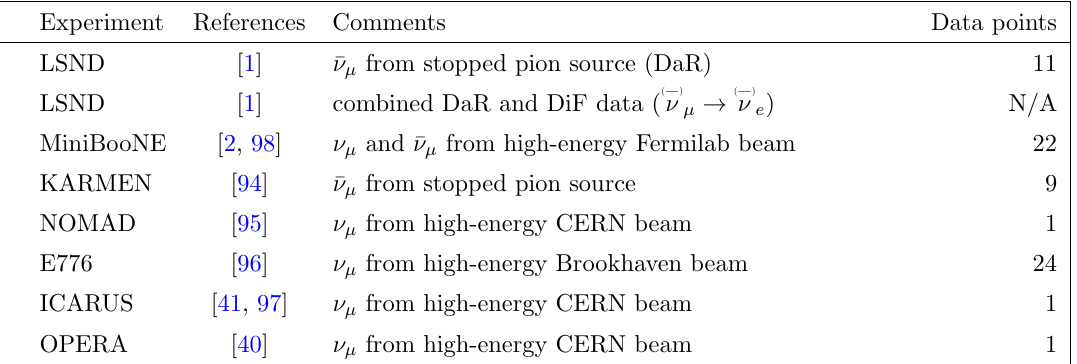
Table 3 . Experimental data sets included in our ( out analyses using only decay-at-rest (DaR) data, or the combination with decay-in-(cid:13)ight (DiF) data. In the latter case we use a (cid:31) 2 table provided by the collaboration, which cannot be associated with a number of data points. The total number of data points in the appearance channel (when using LSND DaR data only) is